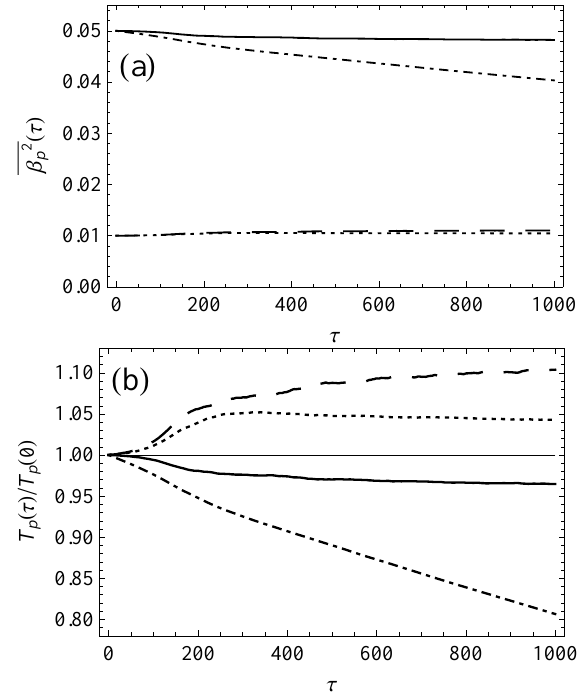
Fig. 6. (a) Normalized proton temperatures as a function of time for both hybrid simulations (with and without expansion). Dotted and dot-dashed curves correspond to parallel and perpendicular temper- atures in the expanding box model simulation (with (cid:15) = 10 − 4 ), re- spectively. On the other hand, dashed and solid curves correspond to parallel and perpendicular temperatures for simple hybrid simu- lations ( (cid:15) = 0). (b) The same evolution shown in panel (a) , but with respect to the initial values of both temperatures for the simple and expanding box simulations.